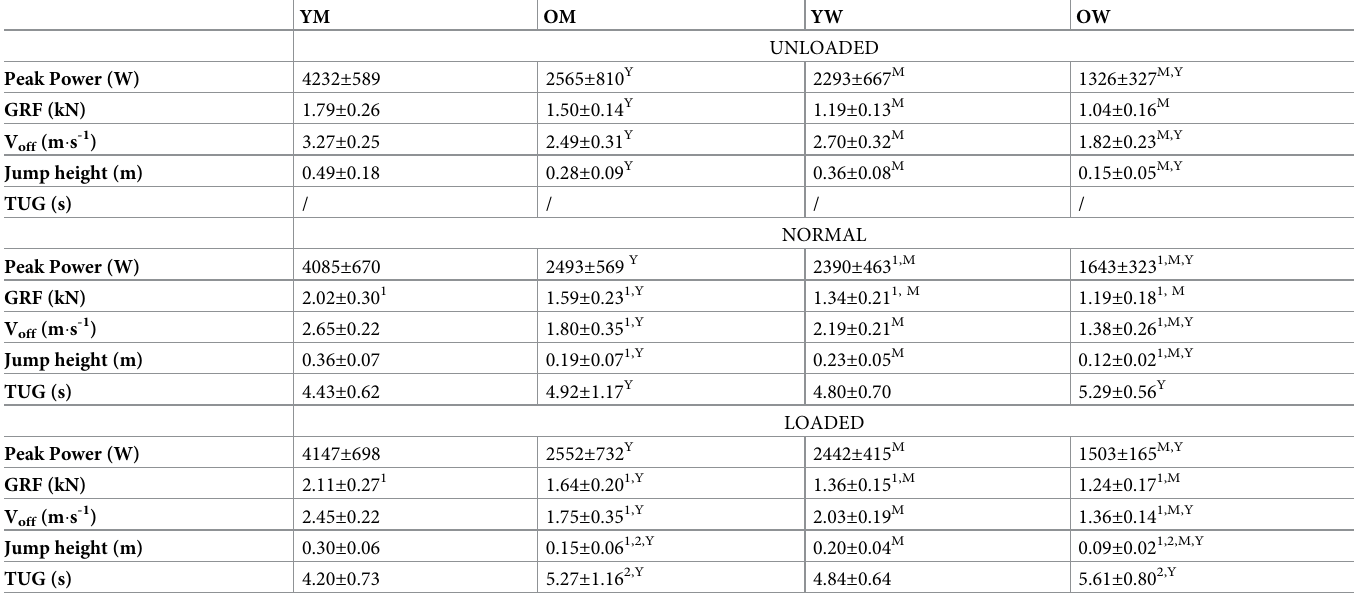
Table 2. Countermovement jump parameters at UNLOADED, NORMAL and LOADED conditions in YM: Young men; OM: Older men; YW: Young women; OW: Older women. YM OM YW